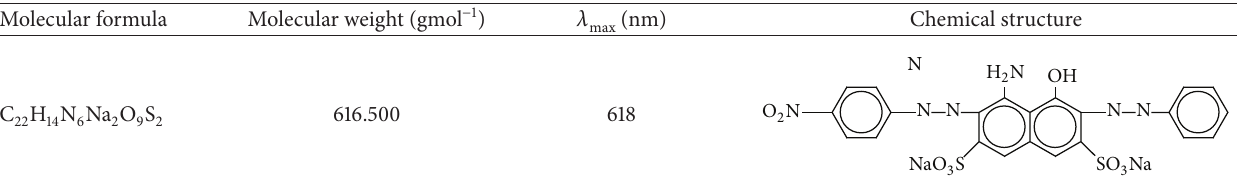
Table 1: Characteristic and chemical structure of